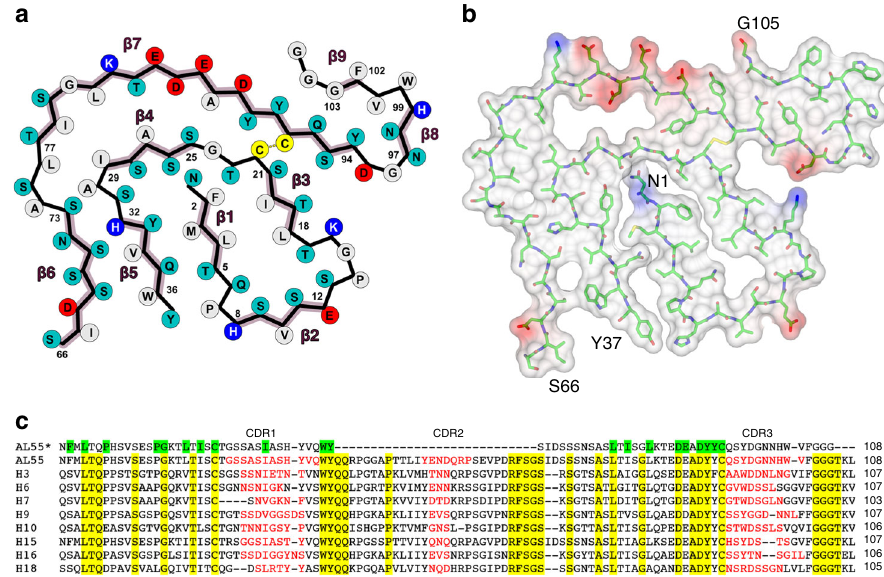
Fig. 5 The fi bril assembly depends on AL55 sequence. a A 2D schematic view of the core polypeptide stretches. Residues are colored as follows: gray hydrophobic, cyan polar, red and blue negatively and positively charged, respectively. b Stick representation of the fi bril core together with a surface representation colored according to electrostatic charges. c AL55 V l is aligned against eight previously reported LCs responsible for severe cardiac amyloidosis; such LCs display highly diversi fi ed sequences and belong to distinct germlines 6 . The fi rst line shows only AL55 residues modeled in the map. Residues considered particularly relevant in determining AL55 fi bril structured core fold are highlighted in green. Conserved residues are highlighted in yellow. The nine LCs here aligned belong to the following germlines: AL55 IGLV6 – 57 ; H3 IGLV1 – 44 ; H6 IGLV1 – 51 ; H7 IGLV1 – 51 ; H9 IGLV2-8 ; H10 IGLV1 – 36 ; H15 IGLV6 – 57 ; H16 IGLV2 – 14 ; H18 IGLV3 –